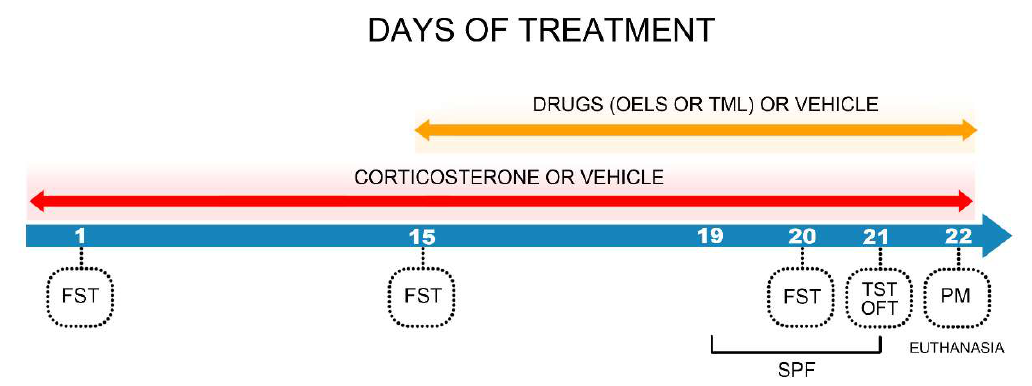
Figure 1. Experimental design. Numbers represent the days of treatment and setting experiments. FST = forced swim test, TST = tail suspension test, OFT = open field test, PM = elevated plus maze test, SPF = sucrose preference test, OELS = Lippia sidoides essential oil, TML = thymol.